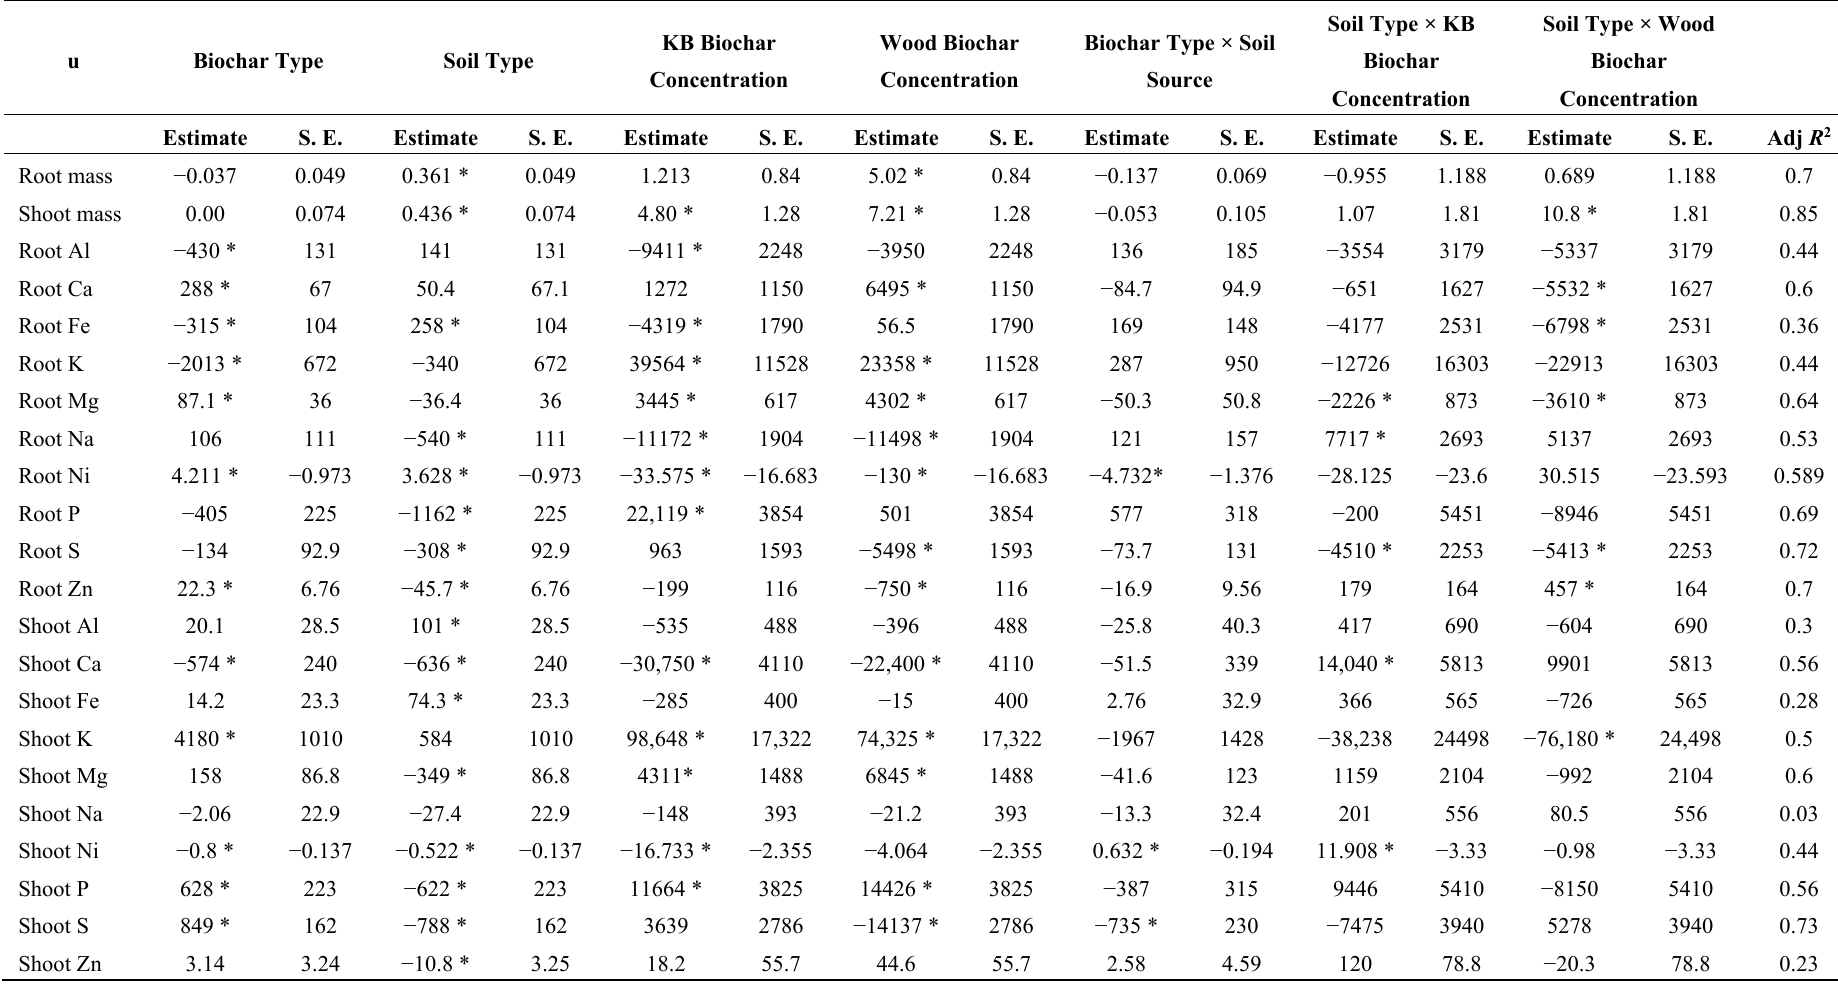
Table 1. The elemental compositions of the root and shoot (mg/kg) were statistically analyzed using the General Linear Model (A+B+C+D+BC+BD+CD+BCD) that included planned comparisons testing whether the linear and quadratic components were significant. The asterisk indicates estimates that are statistically significant ( p ≤